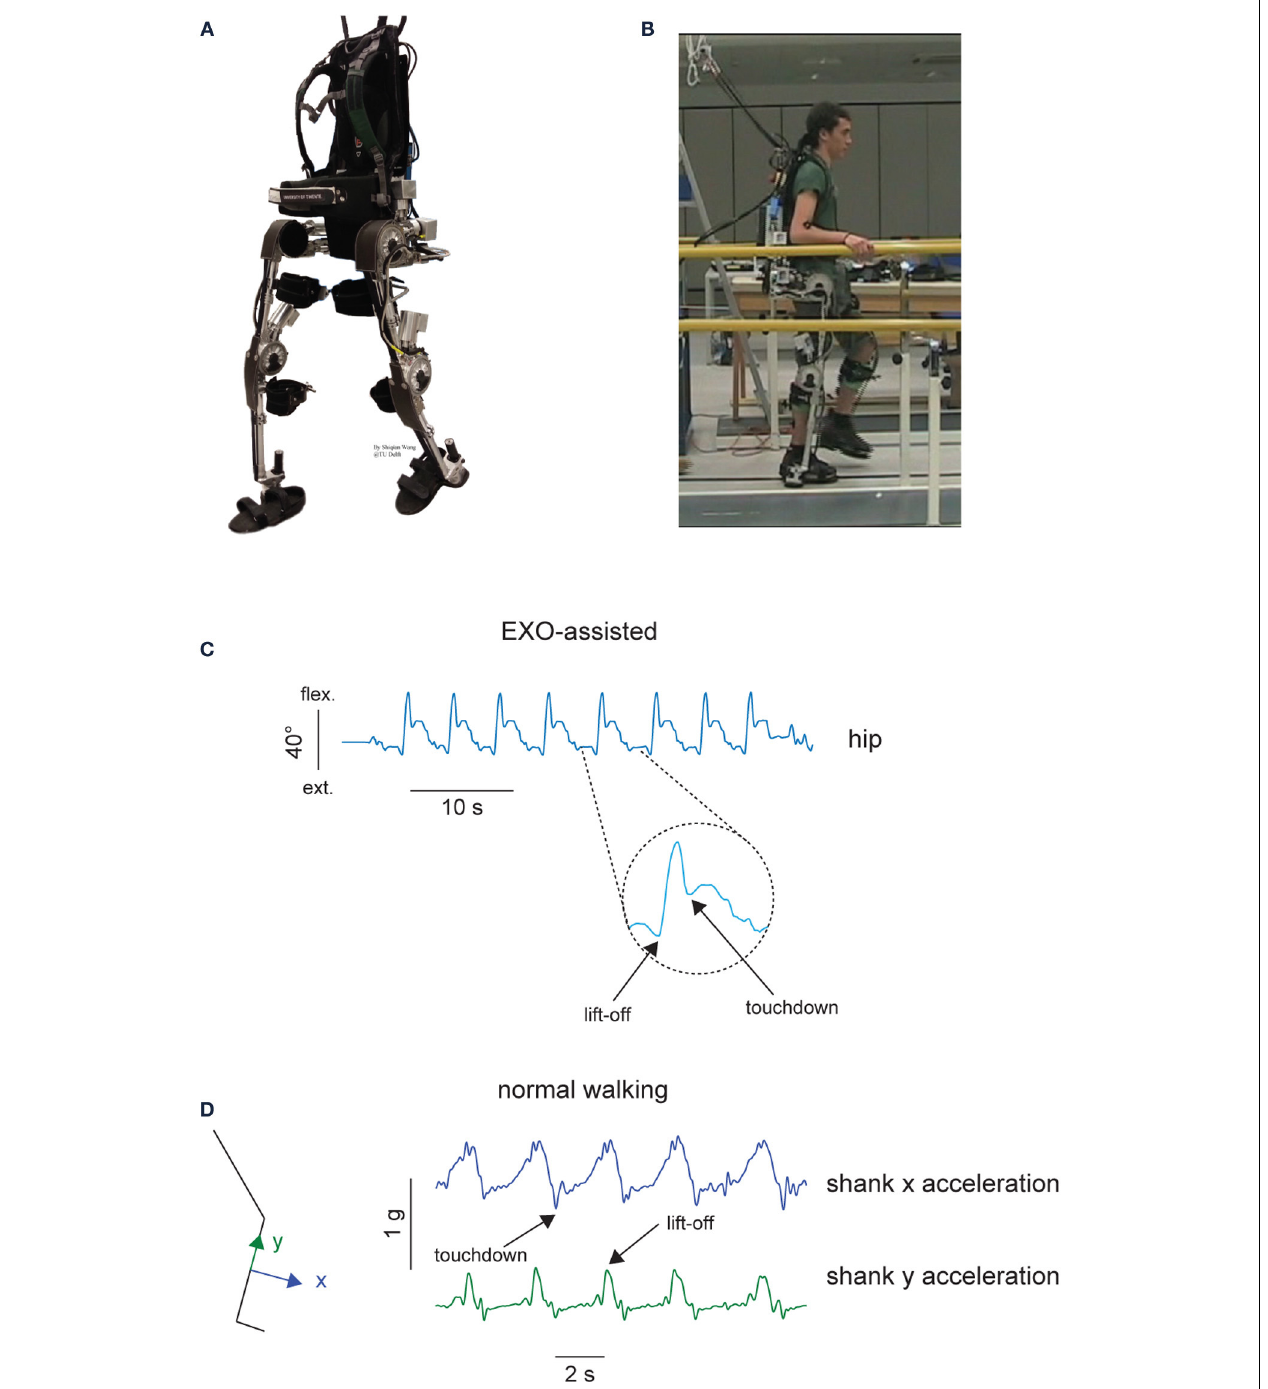
FIGURE 1 | Experimental setup. (A) MINDWALKER exoskeleton. Each leg has five degrees of freedom. Shank and thigh segments have telescopic tubular structure to accommodate different subject statues. The exoskeleton is attached to the wearer at five main locations: footplate, shank, thigh, pelvis, and torso. Footplates are made of carbon fiber and have braces to host human feet. Shank braces are used to support most of the weight of the user in standing and walking while